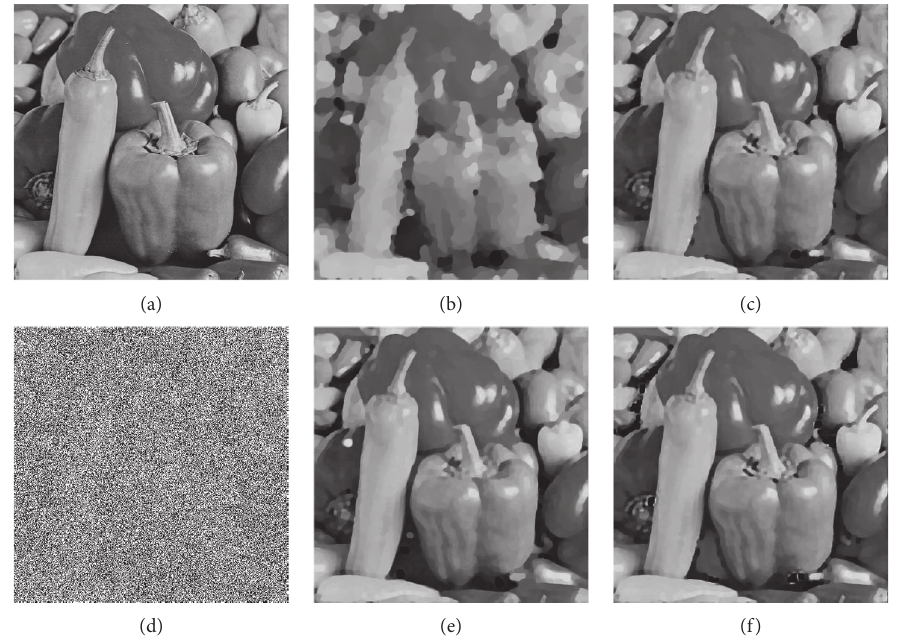
Figure 8: The recovery results (Peppers 512) by Gaussian blur with 90% SP noise. (a) Original. (b) TVL1, PSNR � 18.8935. (c) TVSCAD, PSNR � 24.1732. (d) Gaussian blur (lev � 0.9). (e) TVLog, PSNR � 24.7241. (f) LogTVSCAD, PSNR � 25.6992.